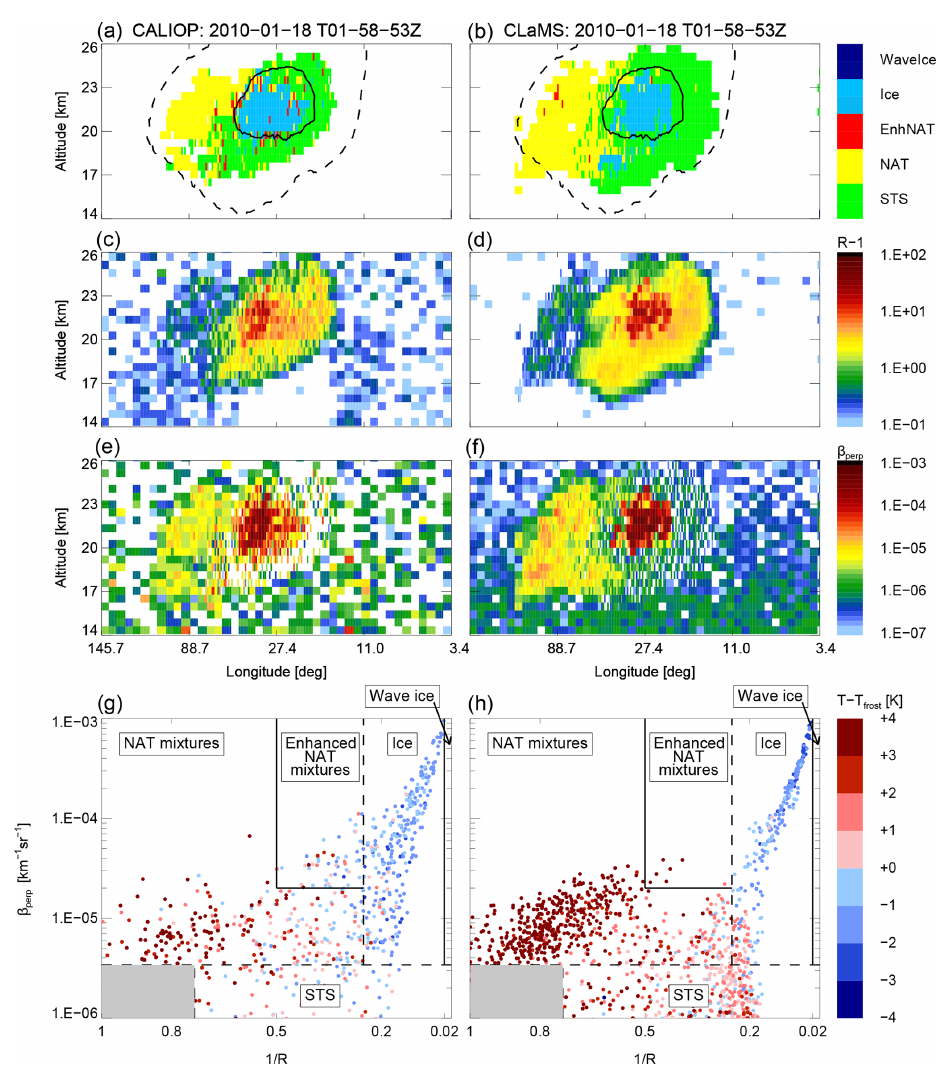
Figure 3. CALIPSO orbit track 2010-01-18T01-58-53Z on 18 January 2010. CALIOP measurements are shown in (a, c, e, g) and corre- sponding model results in (b, d, f, h) . (a, b) CALIOP PSC classification v2 with overlaid temperature contours for T frost (solid line) and T NAT (dashed line); (c, d) aerosol backscatter ratio ( R − 1); (e, f) perpendicular backscatter signal ( β perp ); (g, h) inverse backscatter ratio (1 /R ) vs. perpendicular backscatter signal ( β perp ), with data color-coded by temperatures relative to T frost , and overlaid CALIOP v2 PSC composition classification scheme. Dashed lines are dynamical thresholds ( β perp,threshold , R threshold , and R NAT|ice ) (compare Fig. 4 in Pitts et al.,